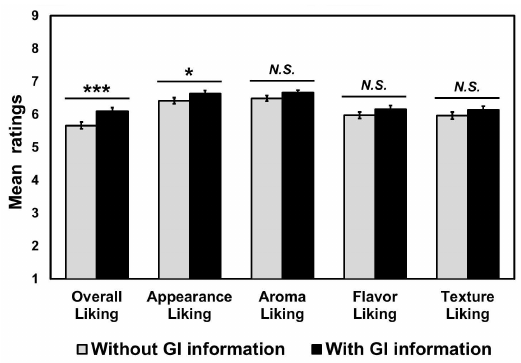
Figure 2. Comparisons among the three cooked aromatic rice samples: ARoma 17 (ARV), Jazzman-2 (LAV), and Thailand Jasmine (THV), with respect to hedonic ratings of attributes and overall impression. * and ** represent a significant difference at p < 0.05 and p < 0.01, respectively. Different letters with mean ratings within a category indicate a significant difference at p < 0.05. N.S. represents no significant difference at p < 0.05.